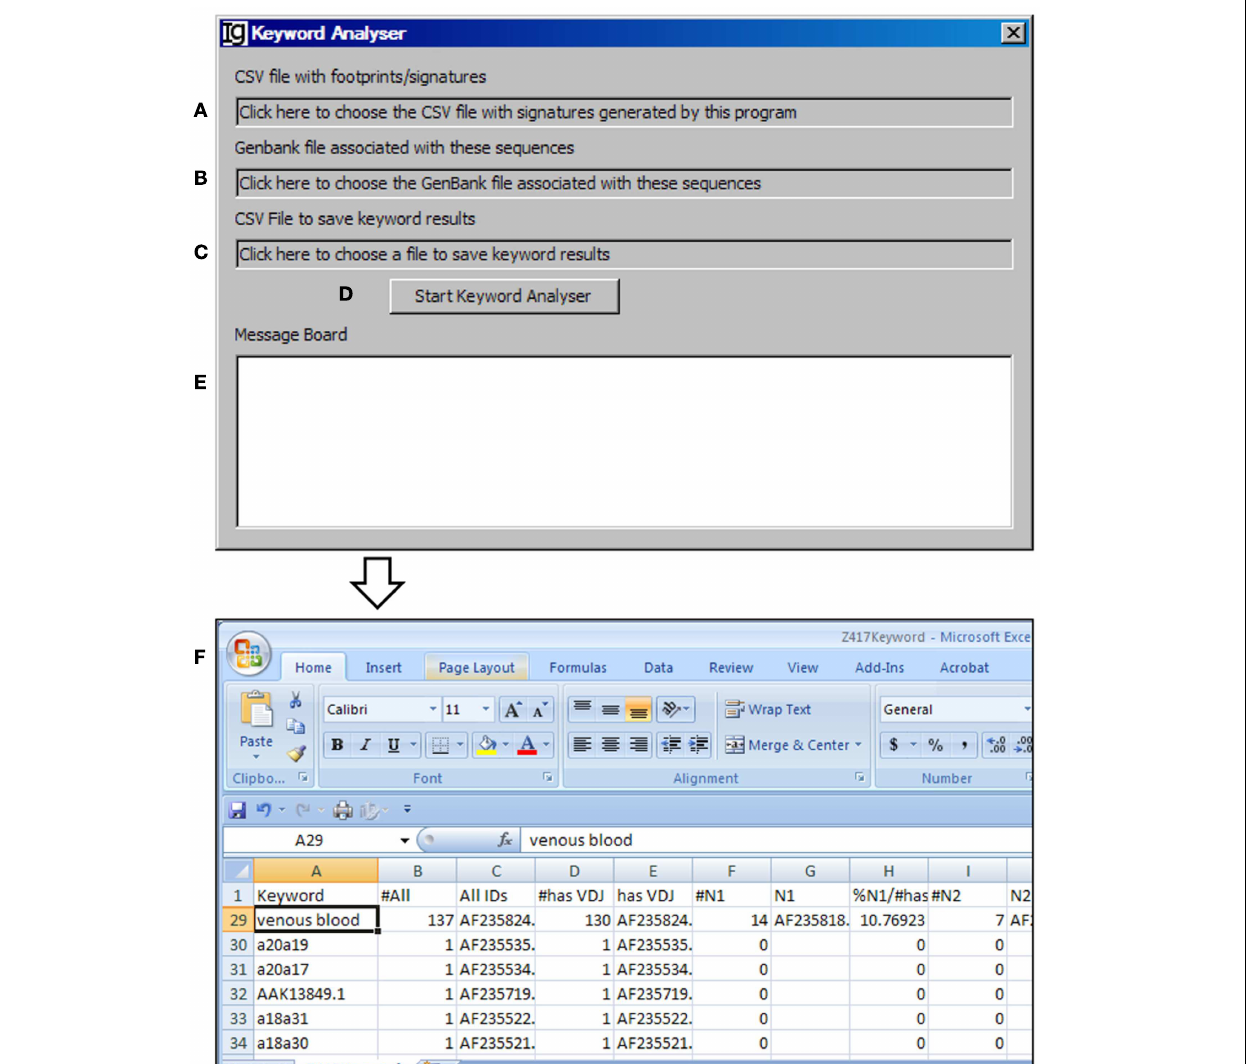
result file ( Figure 6B ), keyword analysis result file ( Figure 6C